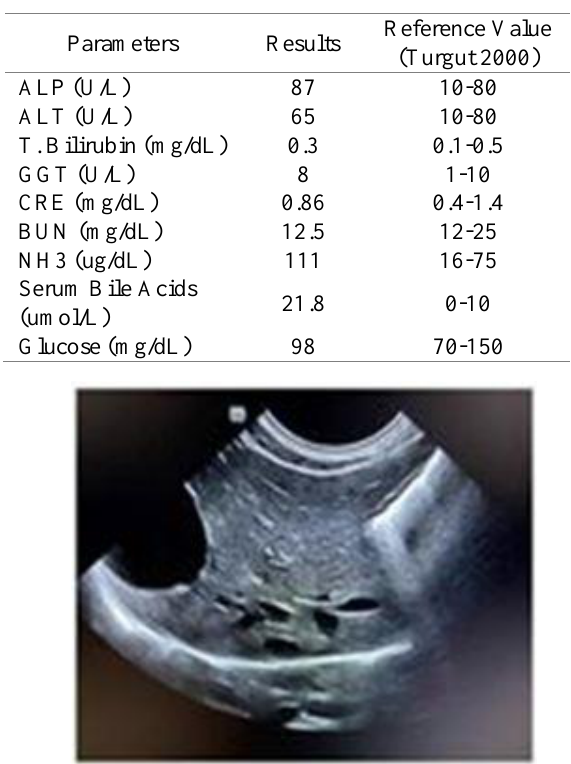
Table 2: Post-treatment laboratory results of the